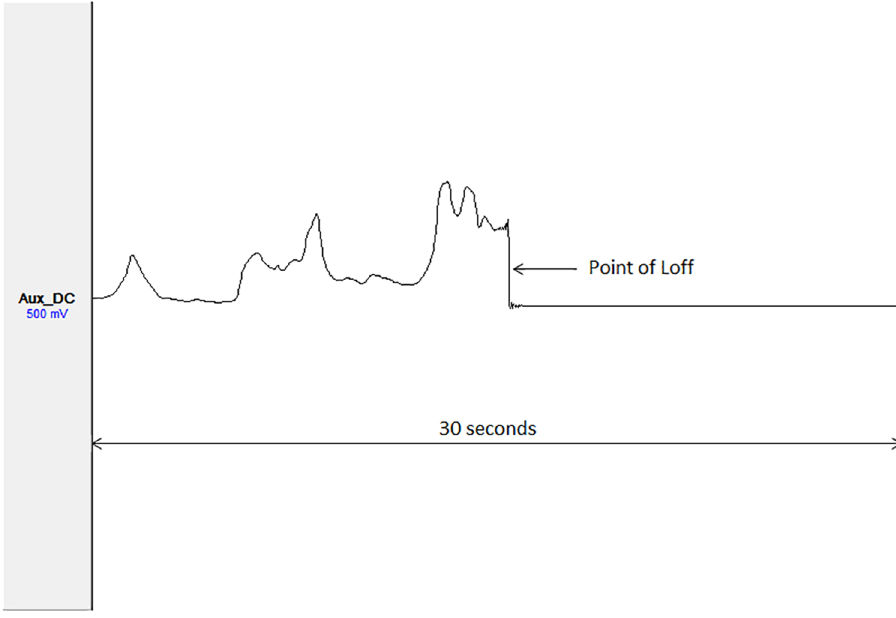
Fig 1. Light sensor (LS) trace example at the point of lights off